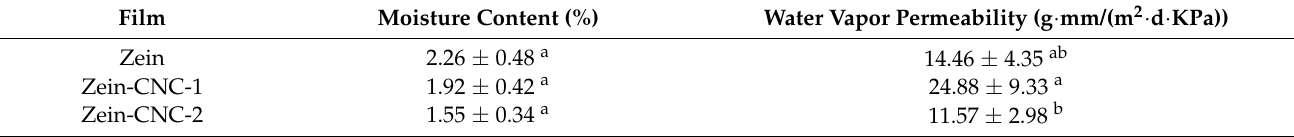
Table 4. The moisture content and water vapor permeability of Zein-based films with different adding amounts of CNC (CNC-1: 0.25%; CNC-2: 5%). Different letters (a–c) in the same column indicated significant differences ( p < 0.05).